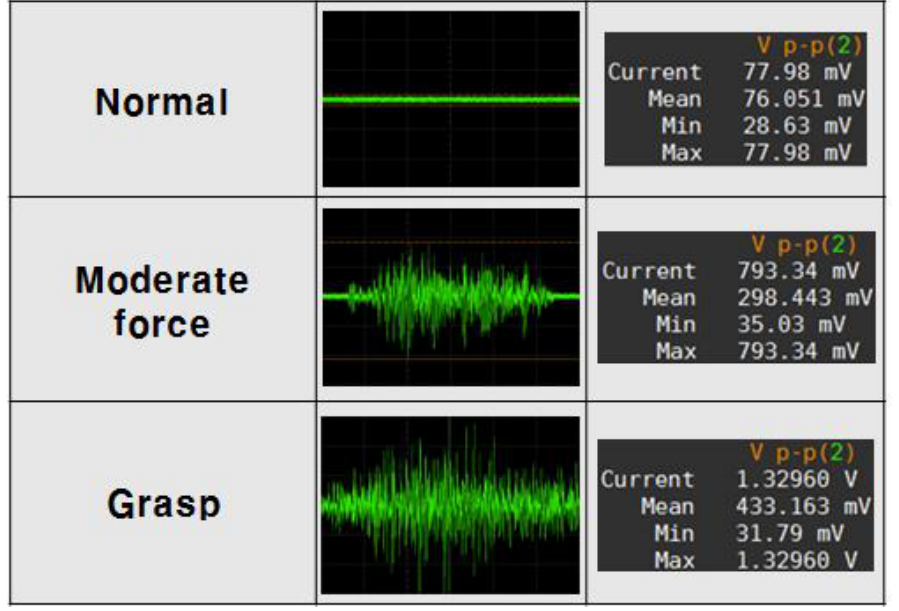
Figure 2. EMG signal according to muscle strength. EMG signal is output in proportion to the subject’s muscle force.